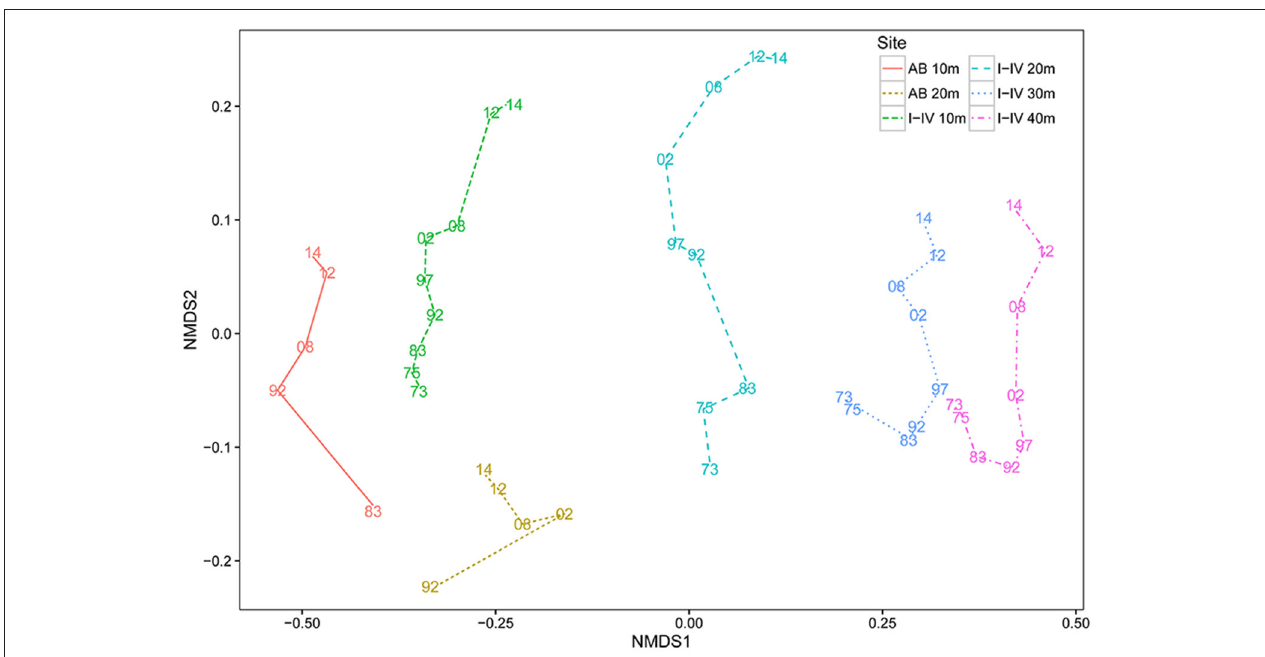
FIGURE 2 | Coral community dynamics on Curaçao and Bonaire. Non-metric Multi-Dimensional Scaling ordinations (nMDS) displaying mean community development over time of sites I-IV, separated by depth (I-IV-10 m, I-IV-20 m, I-IV-30 m, I-IV-40 m) and the reference site Awa Blancu 10 and 20m (AB-10m and AB-20 m). Each color-line type combination corresponds to a specific site-depth combination. Lines represent the degree and direction of community change between two surveys. All surveys are labeled as the last two numbers of the year a survey was conducted. The closer the distance between two points, the more similar in composition they